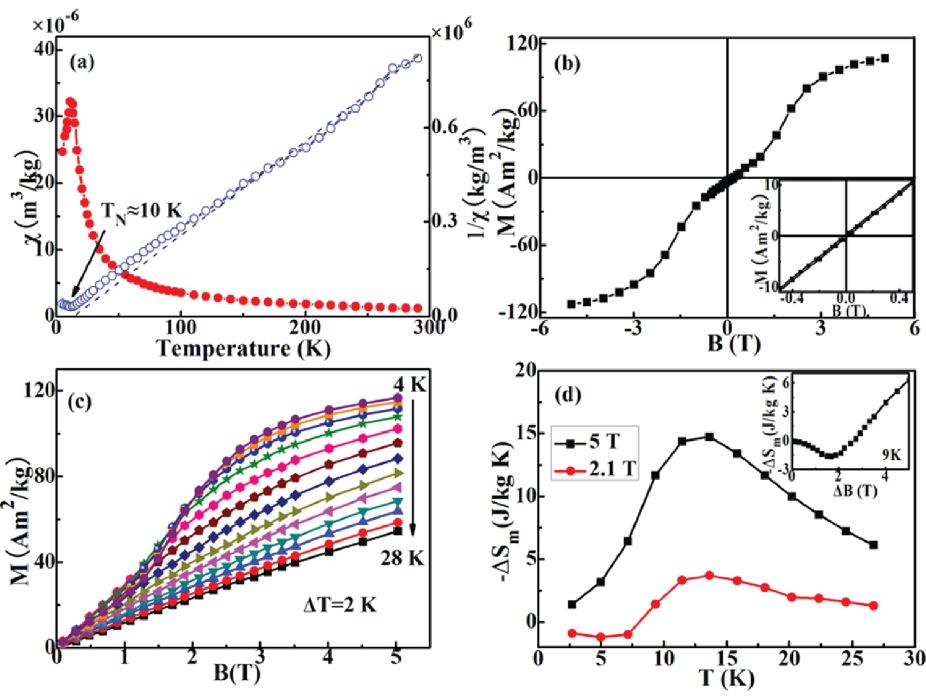
Figure 2. (a) Temperature dependence of the magnetic susceptibility and the inverse magnetic susceptibility of Co(OH) applied magnetic field of 0.01 T. (b) Magnetic hysteresis loop of at 5 K in applied fields up to 5 T. Inset: the hysteresis loop at 5 K in low fields. (c) Magnetic isotherms of Co(OH) measured between 4 and 28 K with a temperature step of 2 K. (d) Negative magnetic-entropy 2 change – Δ S verse temperature T curves for different magnetic field changes ( Δ B). Inset: – Δ S m